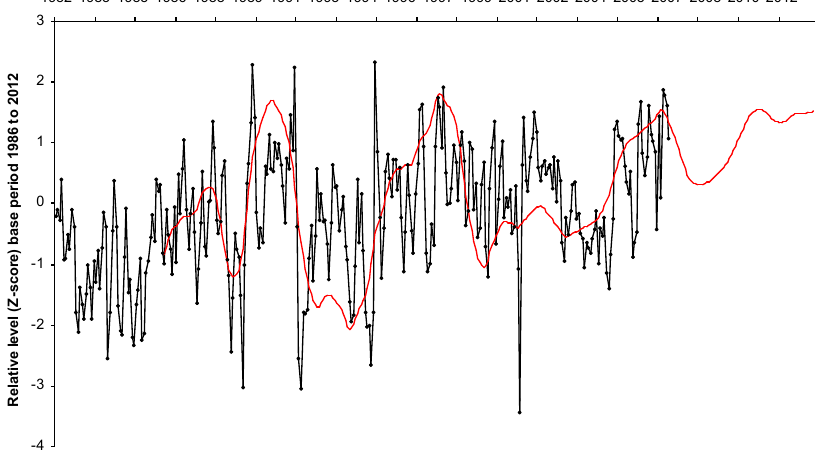
Figure 10. Z -scored monthly data: NDVIG (black dotted curve) compared to NDVIV (red curve).